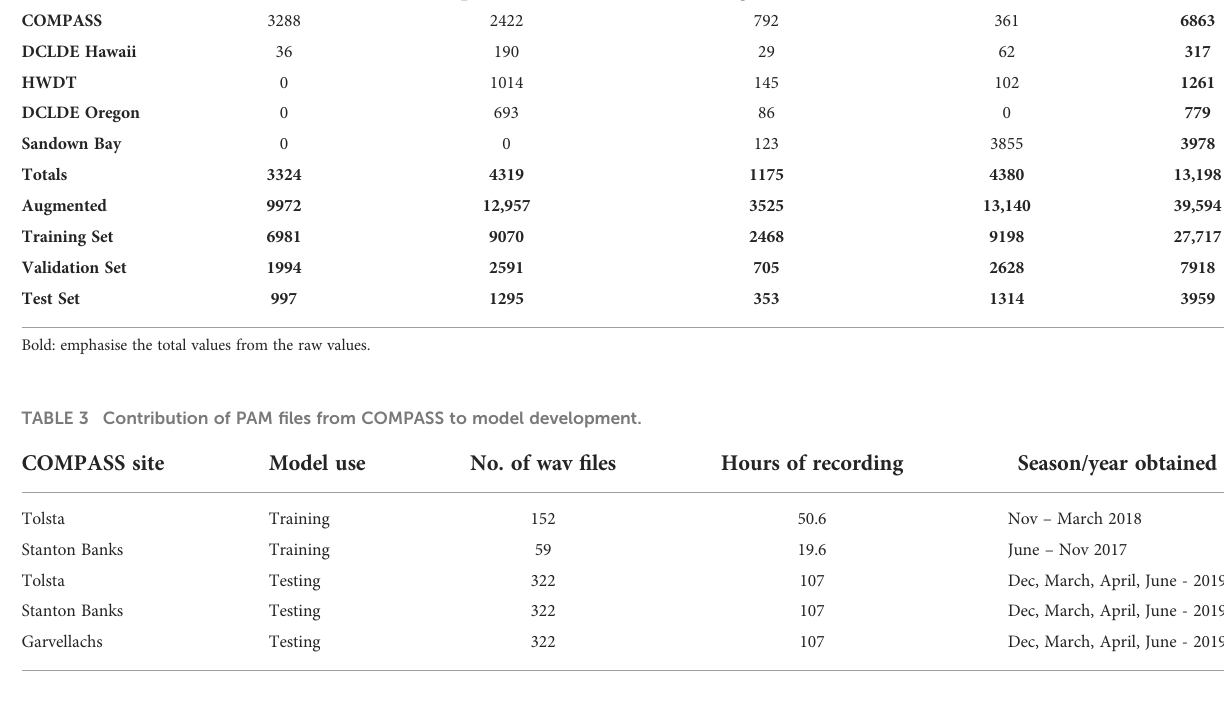
TABLE 2 Composition of training set source signatures, breakdown by dataset of origin, before and after augmentation. .